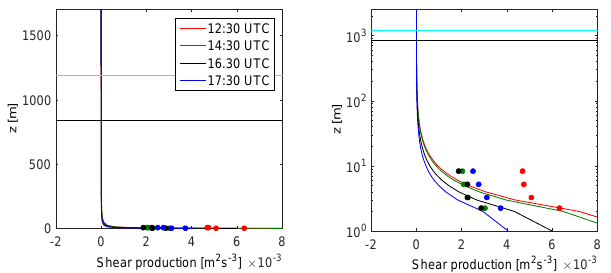
Figure 3. Left panel: modeled (in lines) and observed (in dots) shear production for the afternoon of 20 June. Red, green, black and blue correspond to 12:30, 14:30, 16:30 and 17:30UTC, respec- tively. Horizontal black lines correspond to boundary layer depth z i and the light-blue horizontal line to height of no turbulence z i 0 at 12:30UTC. Right panel: the model and data in a semi-logarithmic representation to better display the near-surface behavior.